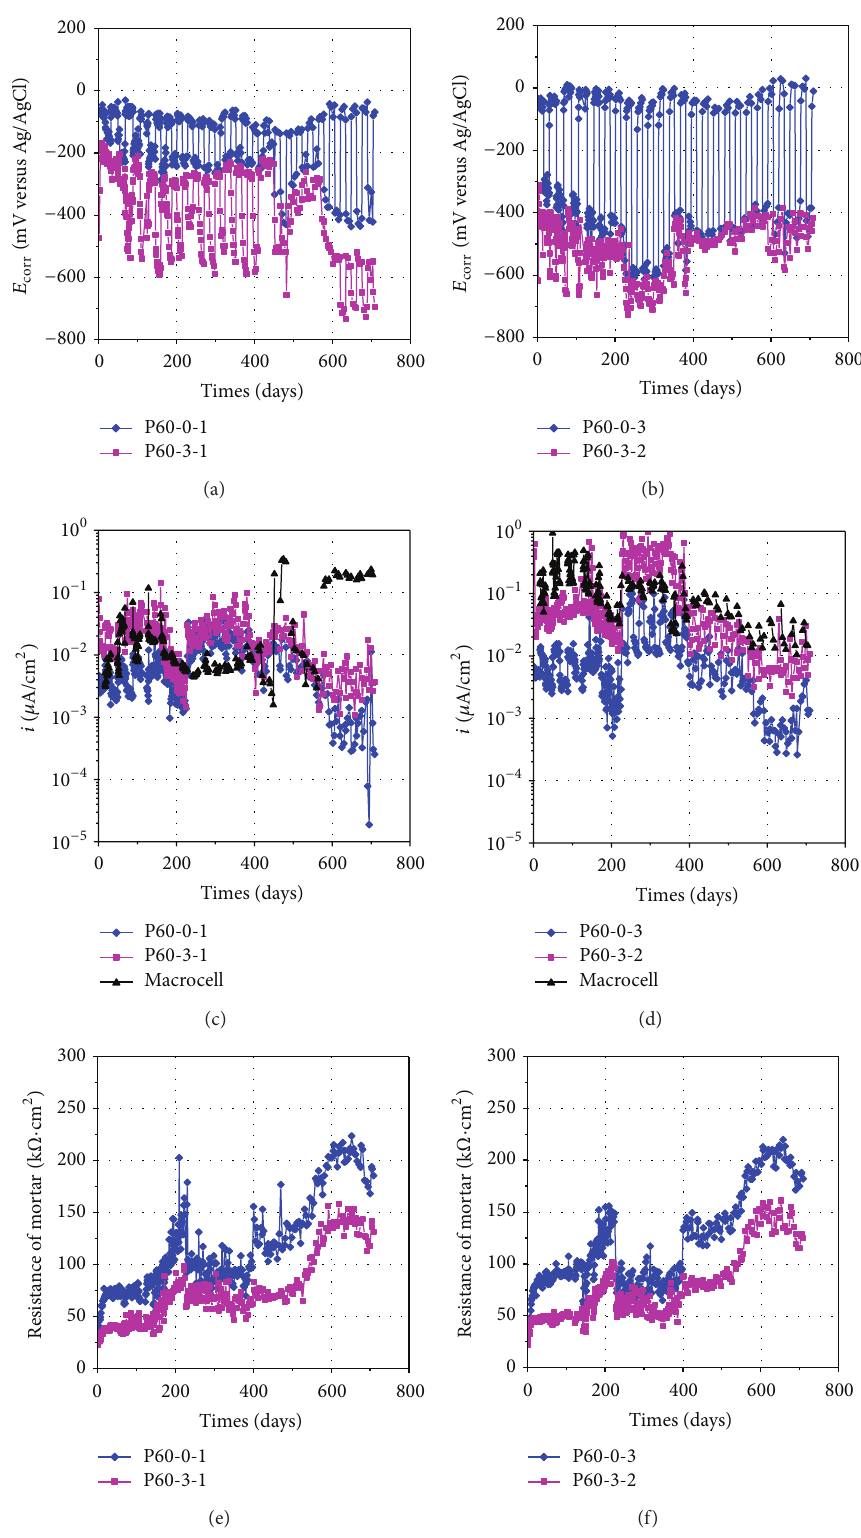
Figure 4: Time evolution curves of half-cell potential, microcell current density, macrocell current density, and resistance of mortars for cases with W/C ratio of 0.60. (a) Half-cell potential of steel in case 10-1, (b) half-cell potential of steel in case 10-2, (c) corrosion current density of steel in case 10-1, (d) corrosion current density of steel in case 10-2, (e) resistance of mortar in case 10-1, and (f) resistance of mortar in case